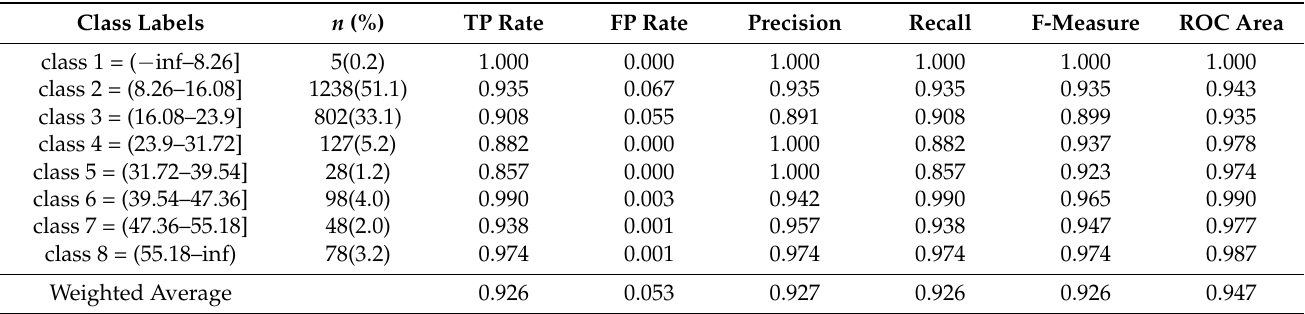
Table 3. Performance evaluation results.